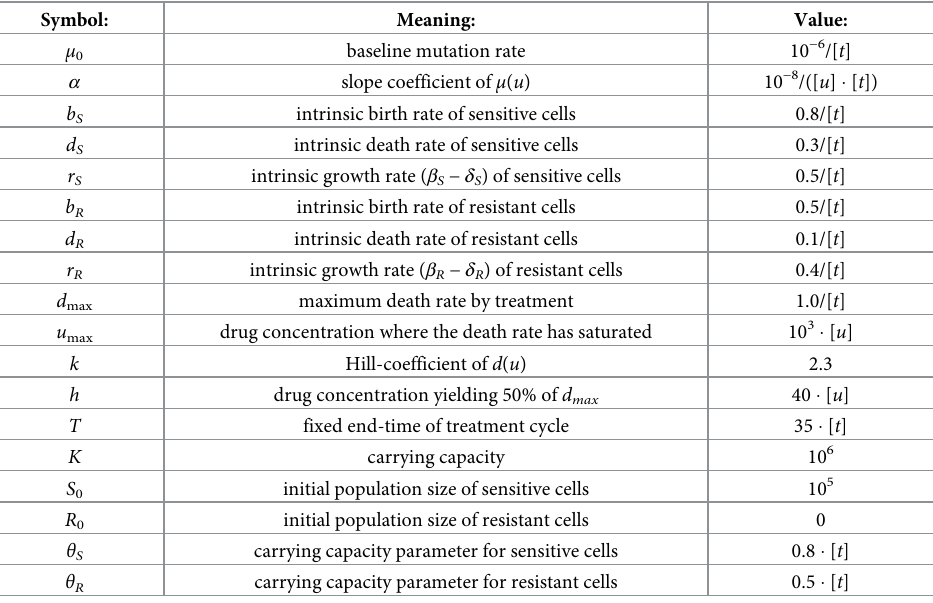
Table 1. Table of parameters used. ([ t ] = unit of time, [ u ] = unit of drug concentration). Symbol: